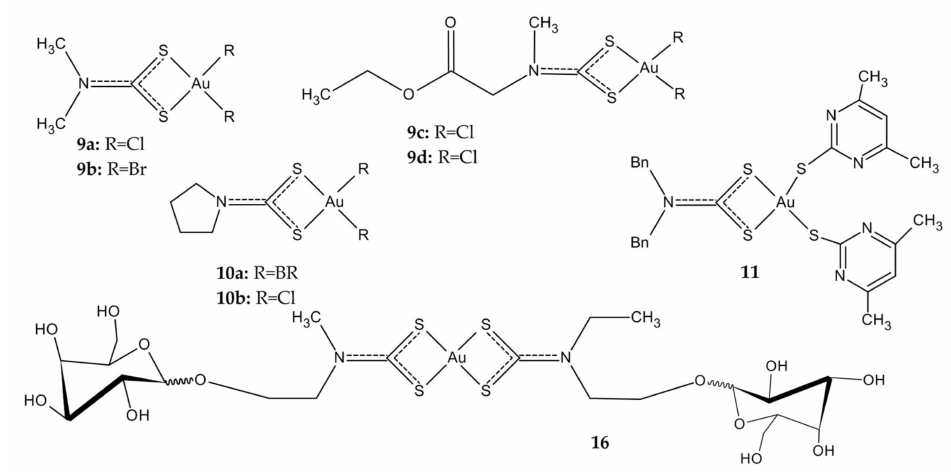
Figure 6. Au(III) dithiocarbamate derivatives 9a – d , 10a , b , 11 , 16 . Treatment with the other two Au(III) compounds based on the pyrrolidinedithiocar- bamates (PDT), 10a,b (Figure 6), showed a rapid (three-hour) dose-dependent decrease in cell viability in the HCT-116 colorectal carcinoma cells. It was found that the bromide derivative 10a was more effective than the chloride one 10b in inducing cell death and acting via elicited oxidative stress, with effects on the permeability transition pore, a mi- tochondrial channel whose opening leads to cell death (Table 2). Cisplatin did not show any cytotoxicity under the same experimental conditions [107]. Greater cytotoxicity of bromides is in agreement with the findings reported by Casini et al. [108] for other Au(III) anticancer